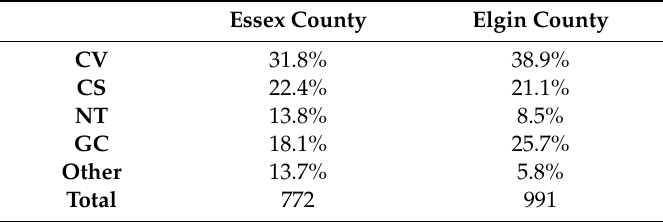
Table 2. Results of the agricultural land management classification survey over Essex and Elgin counties on 18–20 May 2016 respectively. An “other” class was added to denote agricultural activities that were not definable by tillage and green cover management practices, including land uses such as pastures and